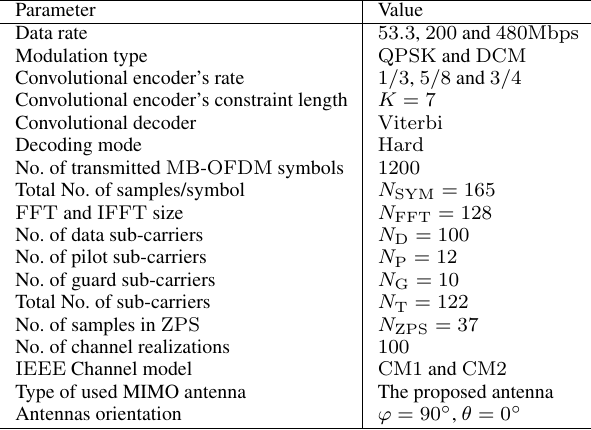
Simulation Parameters of the MB - OFDM ECMA - 368 system Parameter Value Data rate